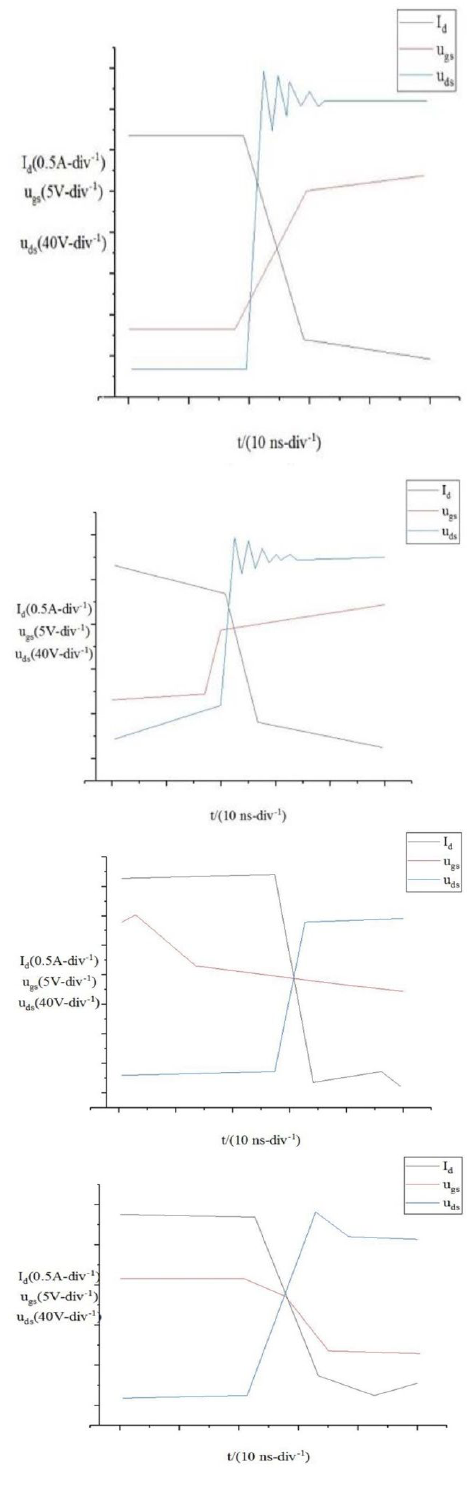
Figure 4: GaN power transistor test and simulation on and off wave- form